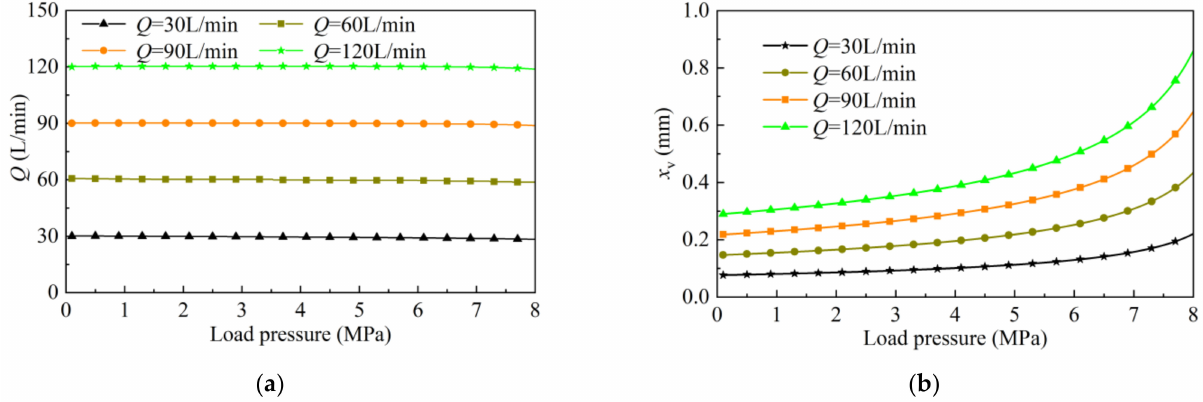
Figure 12. Steady state load characteristic curve. ( a ) Flow rate variation curve; ( b ) valve spool displacement variation